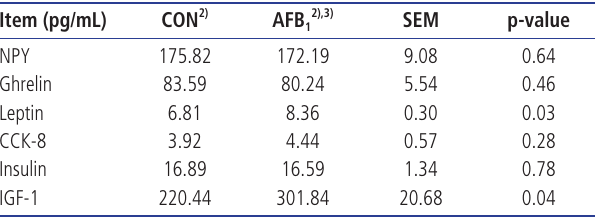
Table 7. Effects of feeding corn naturally contaminated with AFB hormones levels in ducklings 1)